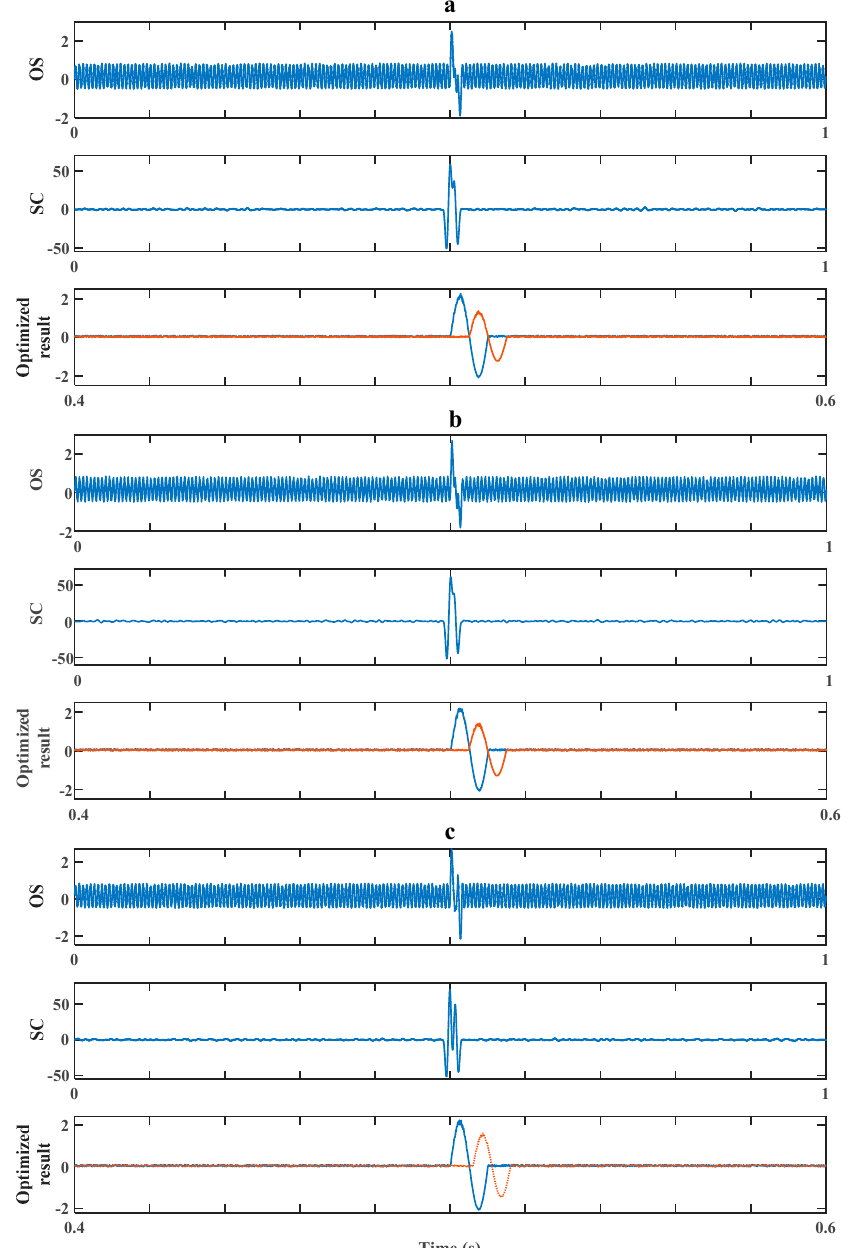
Figure 11. Method’s performance for signals of high SNR while k = 1.2. ( a ) ∆ t = 0.5 T . ( b ) ∆ t = 0.48 T . ( c ) ∆ t = 0.6 T .